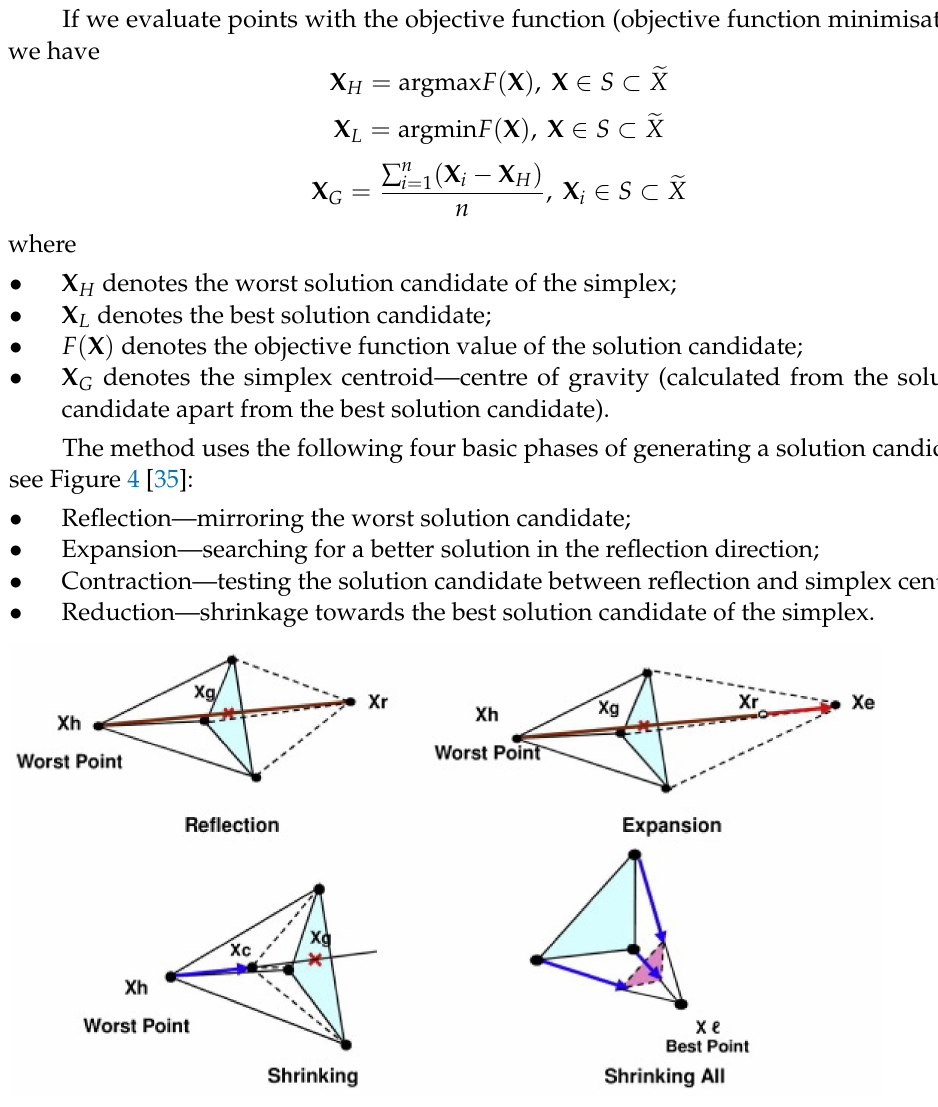
Figure 4. The principle of the Nelder–Mead downhill simplex method